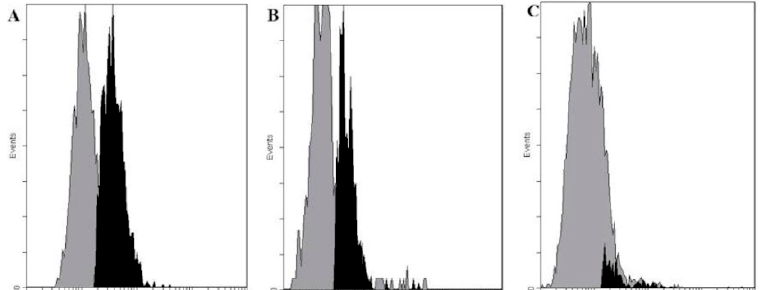
Figure 1. Interaction of human antibodies affinity-isolated using Le C -Sepharose with ( A ) HS758t cells, ( B ) ZR 75-1 cells and ( C ) SKBR-3 cells, flow cytometry data (Cytomics FC 500 Beckman Coulter). The concentration of anti-Le C antibodies was 5 µg/mL (1 µg per 10 6 cells). Cells detached from a monolayer were immediately analyzed using flow cytometry: the gray zone, control (no anti-Le C Abs); the black zone, binding of anti-Le C Abs to cells. The results of flow cytometry data were processed using the CXP Analysis 2.2 software. ( A ) gray zone, mean fluorescence intensity (MFI) 1.2; black zone, MFI 4.3, 66% of positive cells; ( B ) gray zone, MFI 0.53; black zone, MFI 1.4, 68% of positive cells; ( C ) gray zone, MFI 5.39; black zone, MFI 9.05, 7%, that is, practically no positive cells.